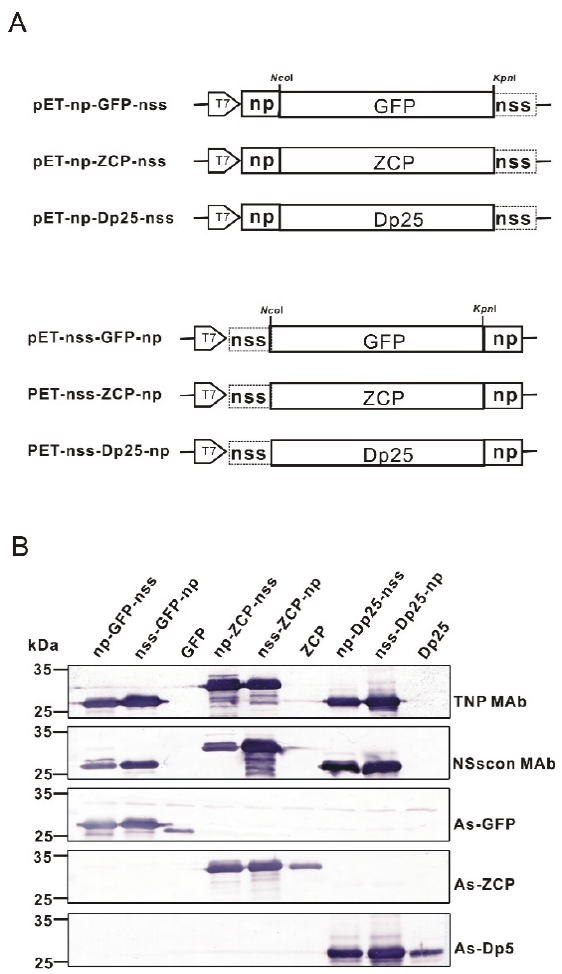
Figure 5. Application of the epitope core sequence KGKEYA of the tomato spot wilt virus (TSWN) NP as a protein tag in the bacteria-expression system. ( A ) Constructions of the bacteria-expressing vector in which the expressed proteins of the green fluorescence protein (GFP), the coat protein of zucchini yellow mosaic virus (ZCP), or the dust mite chimeric allergen (Dp25) were fused with the epitope core sequence KGKEYA of TSWV NP at either the N- or C-terminus. ( B ) Detection of re- combinant proteins tagged with the np sequence KGKEYA by western blotting using TNP MAb (this study), NSscon MAb [37], GFP antiserum (As-GFP) [39], ZCP antiserum (As-ZCP) [39], or Dp5 antiserum (As-Dp5) [39]. 2.5. Co-Immunoprecipitation of np-Tagged or nss-Tagged ZYMV CP In Vitro The interaction of potyviral CP and HC-Pro is essential for the aphid transmission of potyviruses [40–42]. In order to test if the np sequence could be used for a co-immunopre- cipitation analysis of the interacting proteins, the bacteria-expressed np-tagged ZYMV CP was mixed with the non-tagged HC-Pro protein, and the interacting complex was im- munoprecipitated using TNP MAb. Our results showed that the CPs tagged with the np sequence, either at N- or C-terminus, were pulled down by TNP MAb, and the non-tagged HC-Pro was detected by the HC-Pro antiserum in the pulled down fractions, indicating its interaction with the CP (Figure 6). Previously, we have proved that the nss-tag is em- ployed well in co-immunoprecipitation experiments to study the CP and HC-Pro interac- tion [38]. Our results in this investigation demonstrate that the np-tag is also applicable for co-immunoprecipitation to explore protein–protein interactions. In addition, the np- tag and the nss-tag, attached at the N- or C-extreme of the CP, do not interfere with each other.